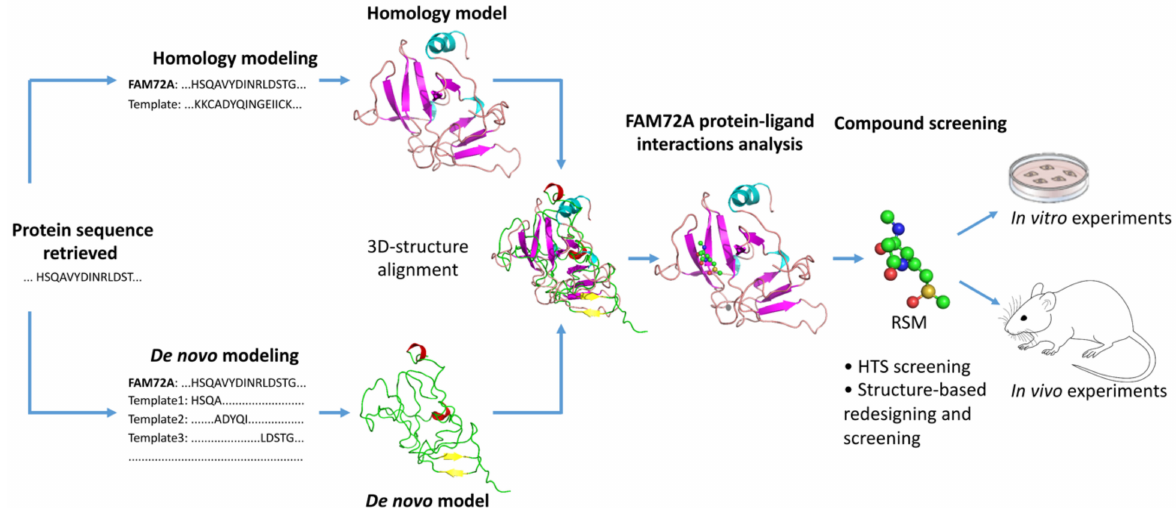
Figure 11. Structure based anti-cancer drug screening for the treatment of FAM72A-mediated cancers. Based on an in silico 3D protein structure model of FAM72A and its ligand-binding sites, the potential hit molecule RSM has been proposed for possible further therapeutic activity evaluations via in vitro and in vivo